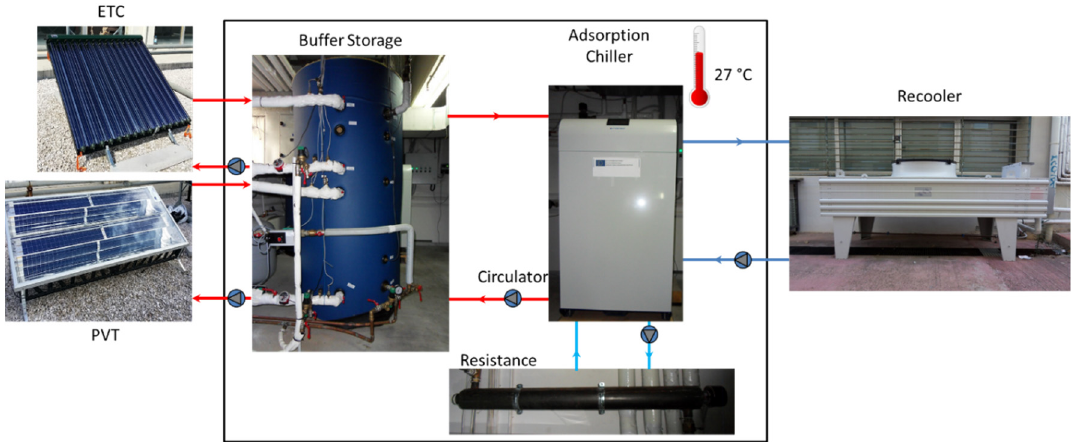
Figure 1. The experimental set up of the solar system.